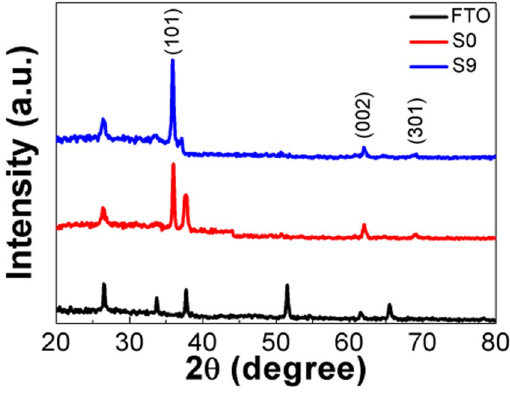
Figure 1. XRD patterns of S0, S9, and FTO